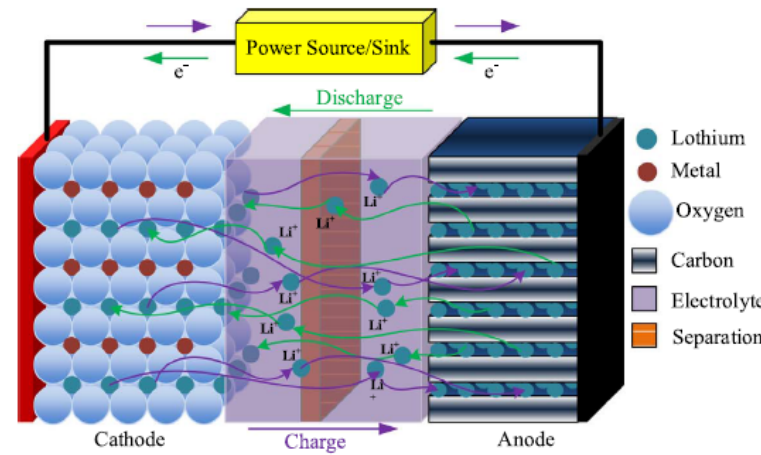
Figure 4. Lithium-ion battery electrochemistry